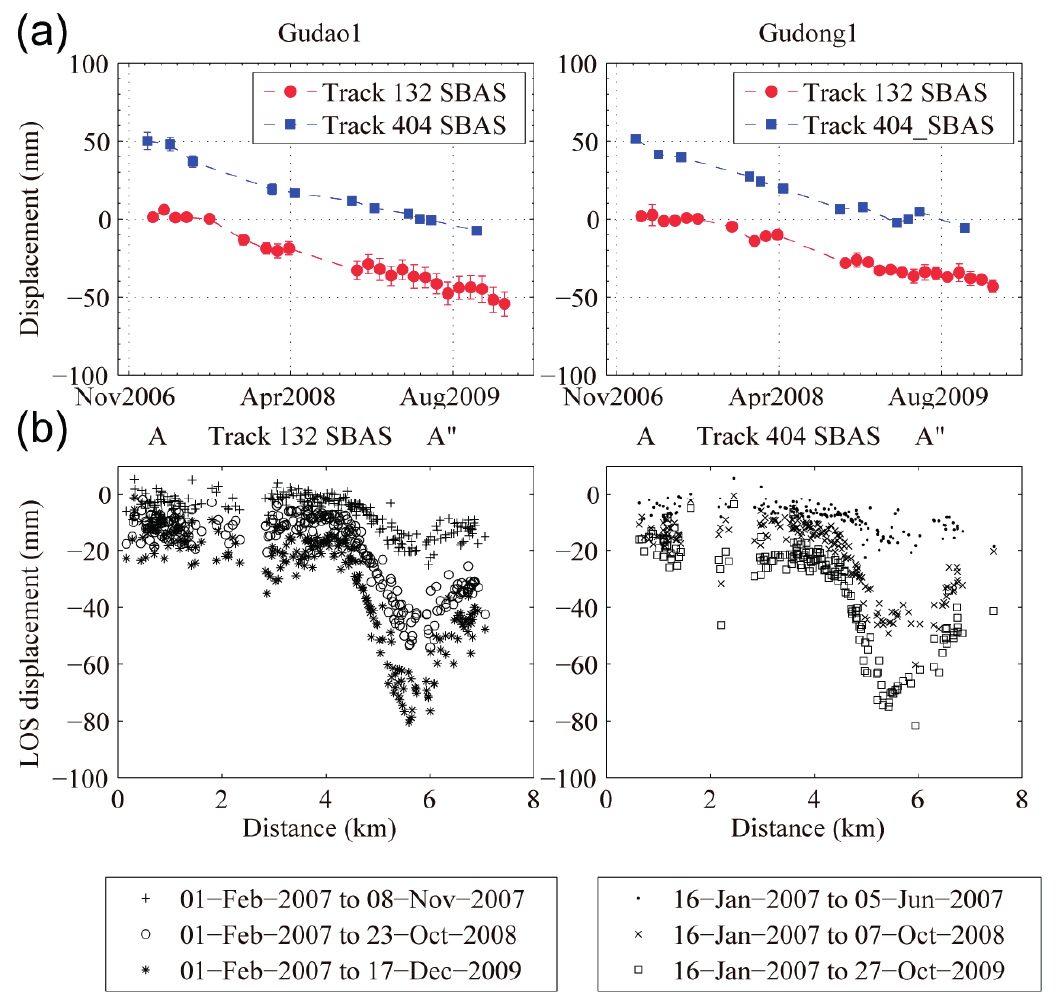
Figure 7. ( a ) Time series of surface displacement at Gudao1 and Gudong1 from Tracks 132 and 404. Error bars represent the standard deviations of the displacement values for all SDFP points within a 200 m × 200 m window, centered with the given point. Displacement offset between Tracks 132 and 404 are due to different reference dates used for different tracks. ( b ) Displacements along Swath A-A" from Tracks 132 and 404 in three